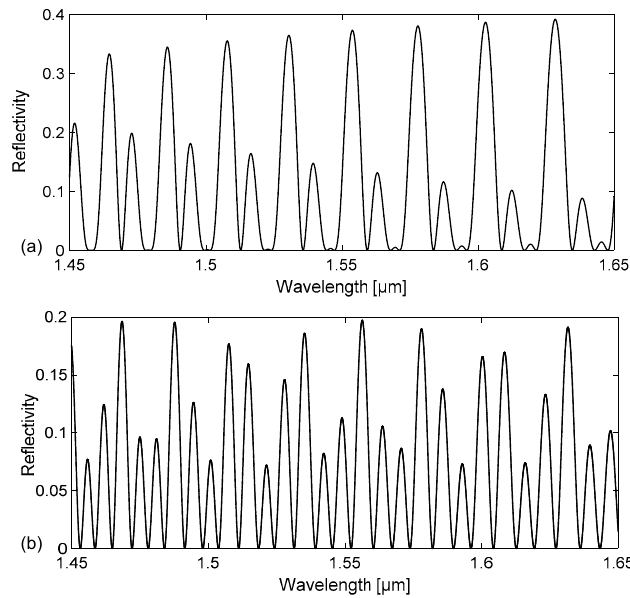
Figure 3. Calculated reflectivity spectra R( λ ) = P r ( λ )/P in ( λ ) for a rectangular – miniature hollow glass tubing with d = 50 µm, t f = t b = 35 µm (nominal dimensions): ( a ) empty channel; ( b ) channel filled with water.